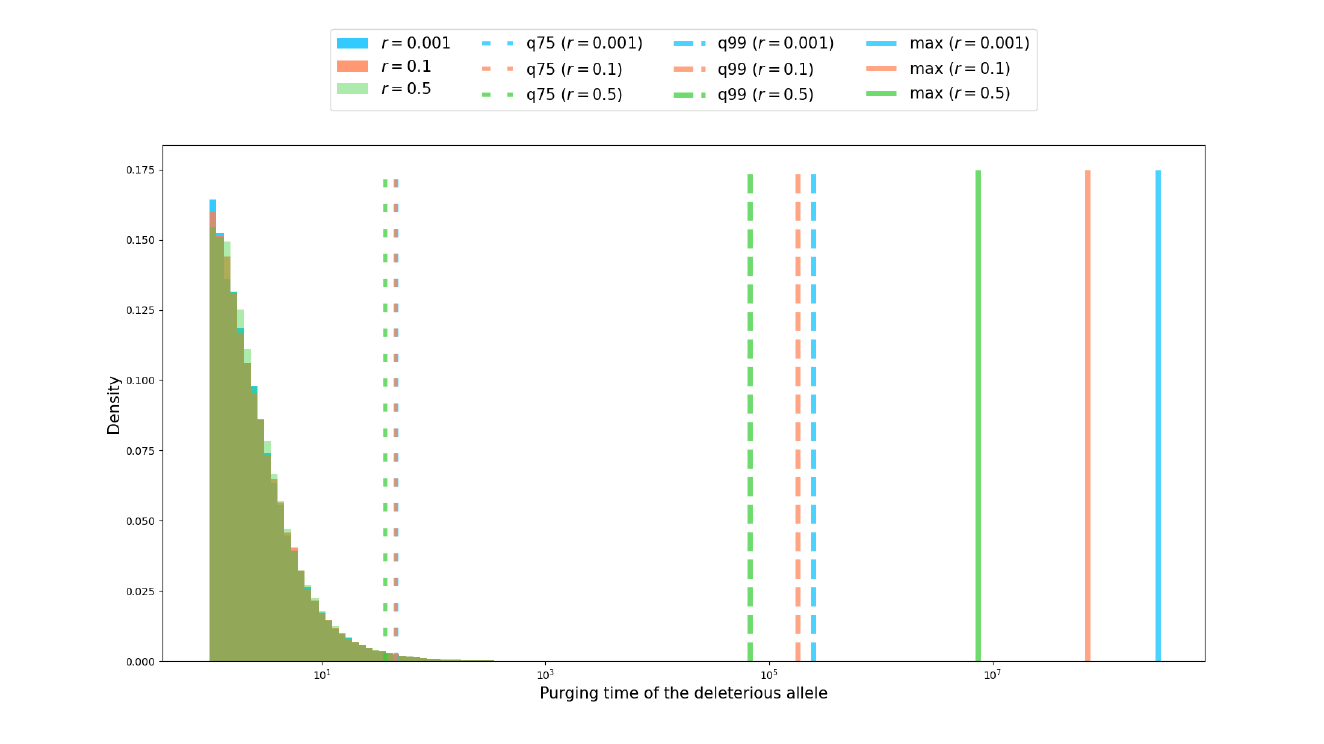
Figure 4 – Empirical distribution of the deleterious allele purging time for the partial dominance scenario. A total of 100,000 simulations were run, with s = 0.1 , h = 0.1 , f = 0.5 , p in = 0.5 , starting from one heterozygous individual ( X 0 = (1, 0, 0) ), and for three values of the recombination rate ( r = 0.001 in blue, r = 0.1 in red and r = 0.5 0.0101 , ρ = 0.0106 and ρ = 0.0307 . in green). The respective values for ρ are ρ = − − − th The x-axis is log-scaled. The large-dotted lines represent the 75 percentile ( q75 ), the th dashed lines indicate the 99 percentile ( q99 ), and solid lines the maximum value ( max ) of the purging time. Maximum values are several order of magnitudes higher than the 75 th percentile of the empirical distribution of the purging